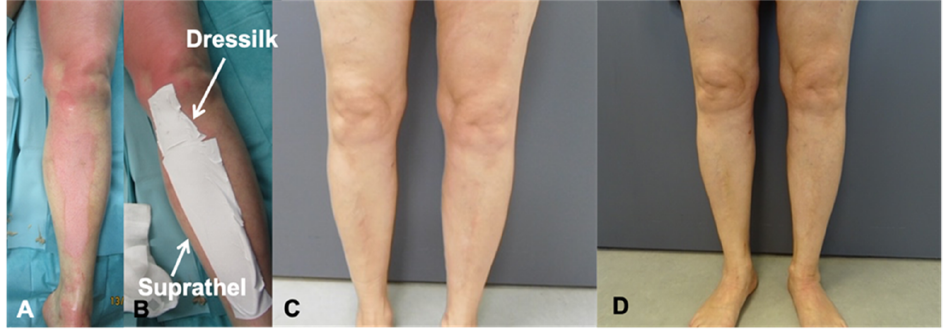
Figure 1. Partial thickness burn of the left leg; ( A , B ) before and after debridement; ( C ) 6-month follow-up; ( D ) 12-month follow-up.